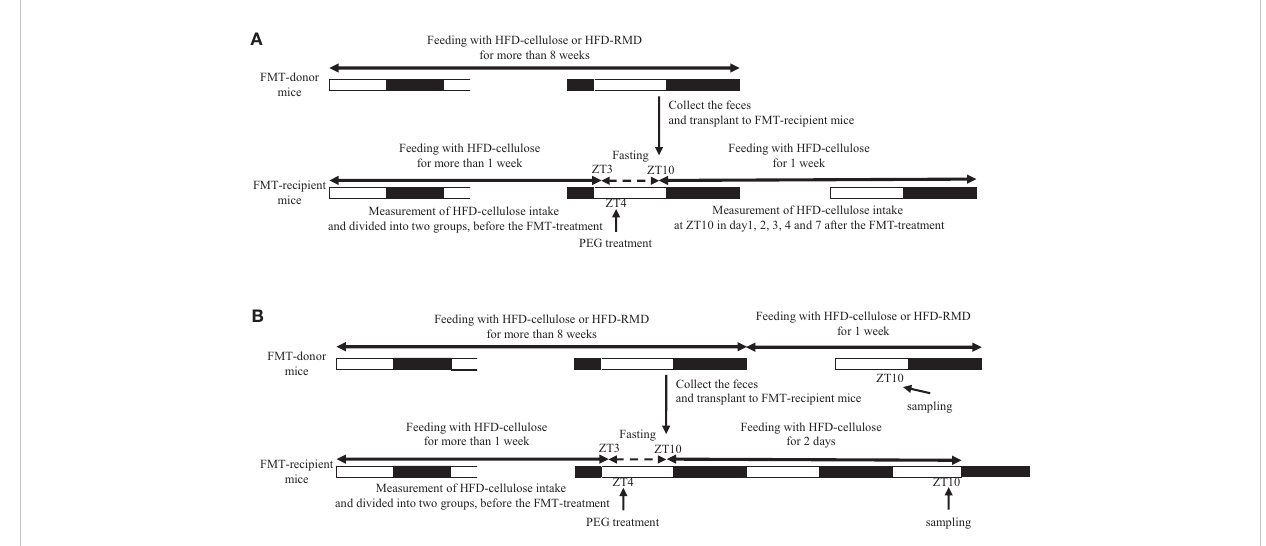
FIGURE 1 Protocols of fecal microbiota transplantation in experiments 2 and 3. Experiments (A) 2 and (B) 3.